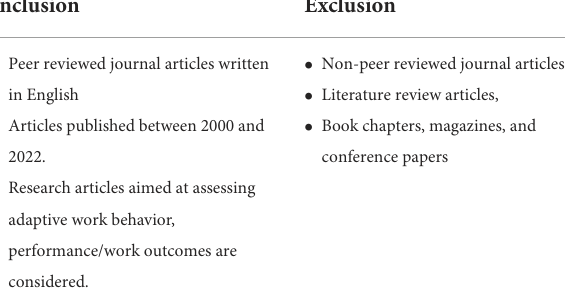
TABLE 2 Inclusion and exclusion